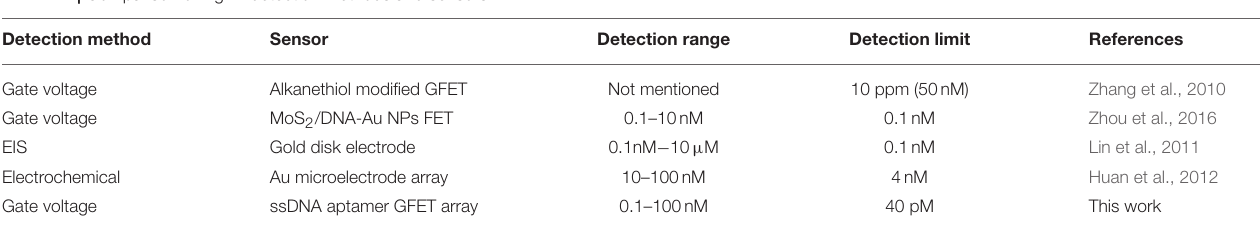
TABLE 1 | Comparison of Hg 2 + detection methods and